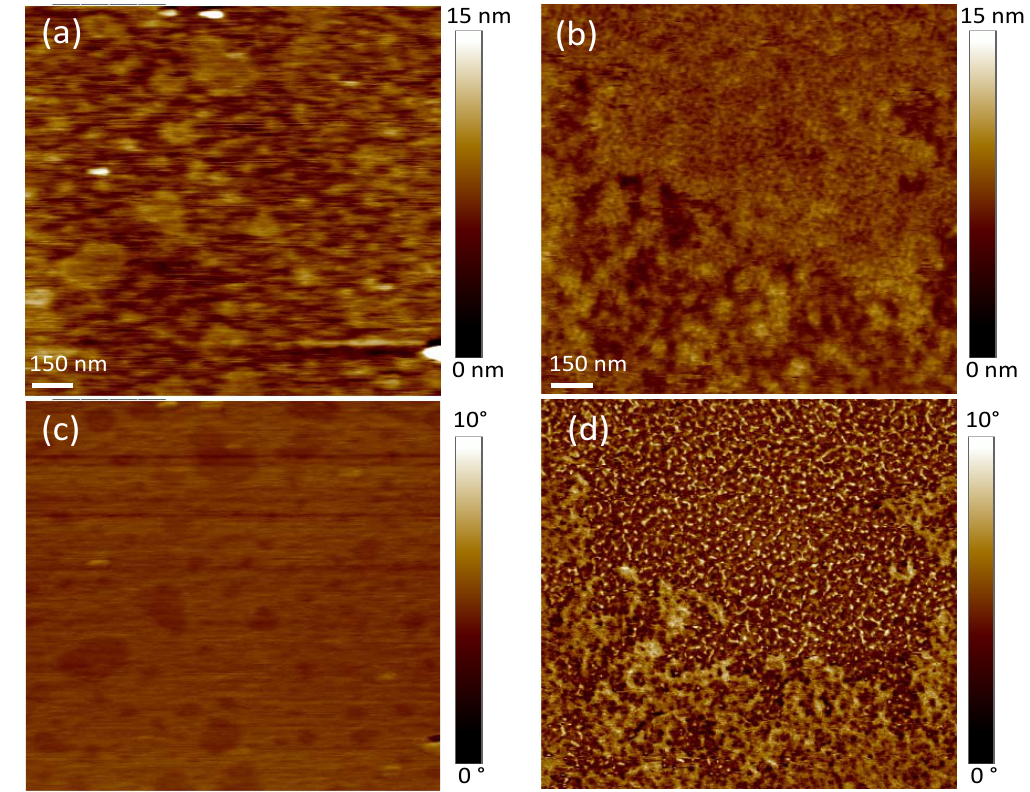
Figure 6. Tapping mode AFM images in deionized water of DMPC (left) or DOPC (right) supported on polydopamine-coated mica (top: height mode, bottom: phase mode, scan size 1.5 µm × 1.5